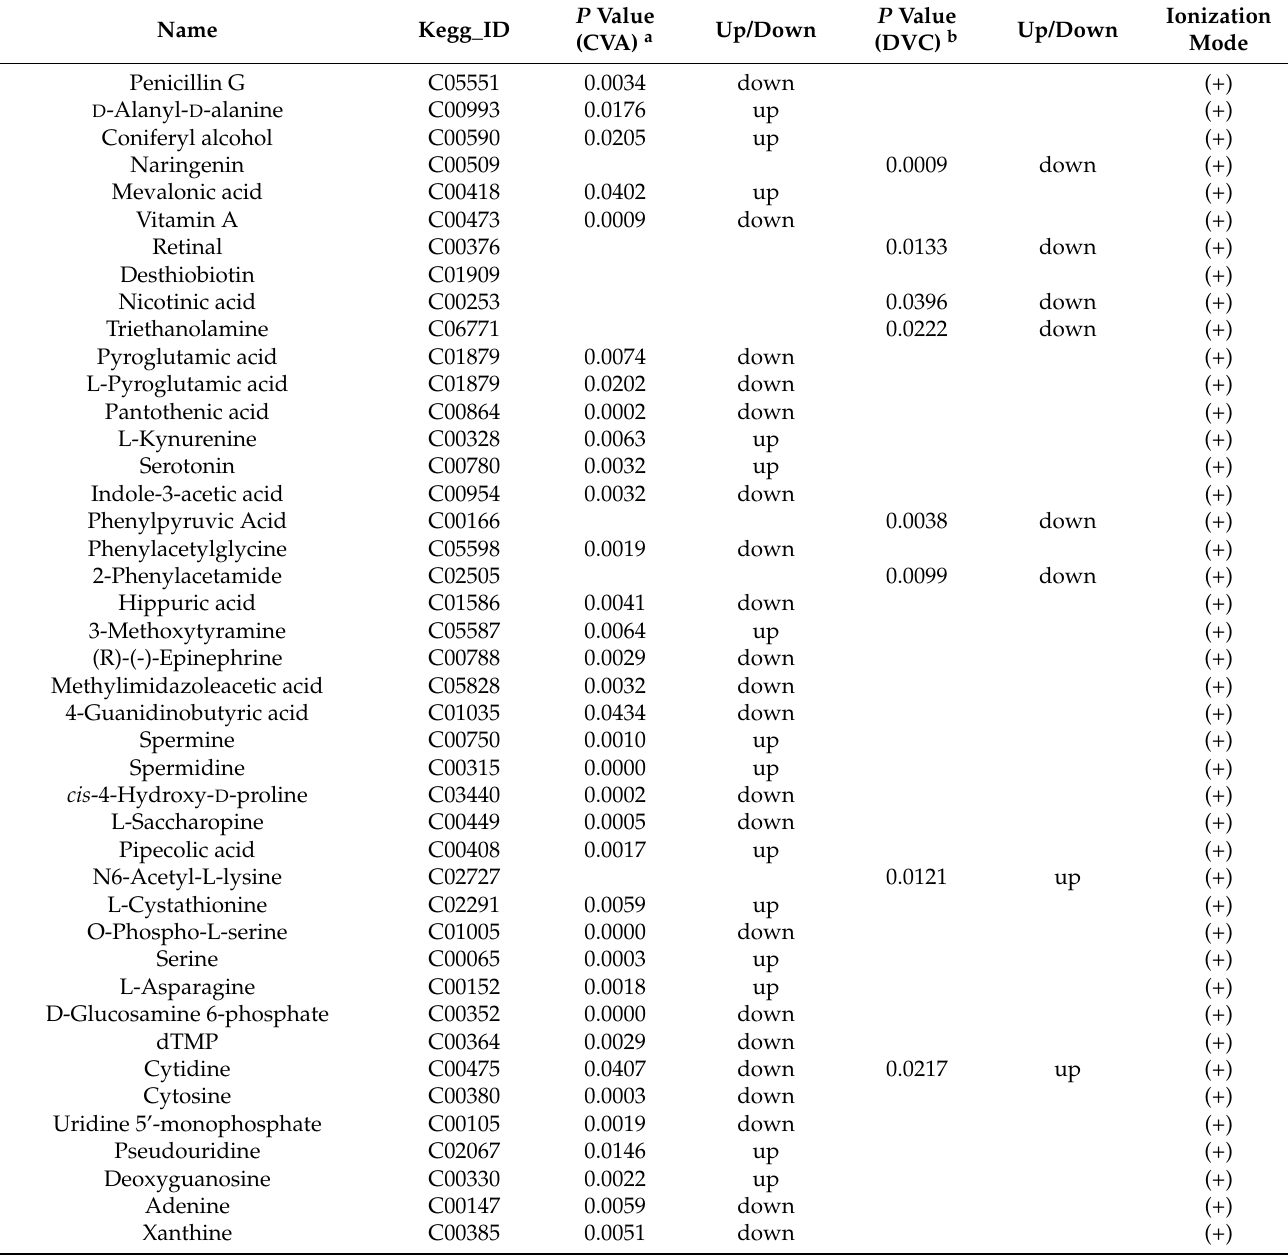
Table 2. The list of biomarkers in CON, DSS and LTD groups ( P value < 0.05 and fold change